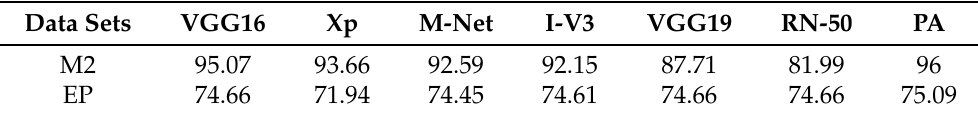
Table 4. Comparison of existing approaches and proposed approach using EyePACS (five cate- gories) and Messidor-2 (two categories) using 10-fold validation. M2 = Messidor-2, EP = EyePACS,